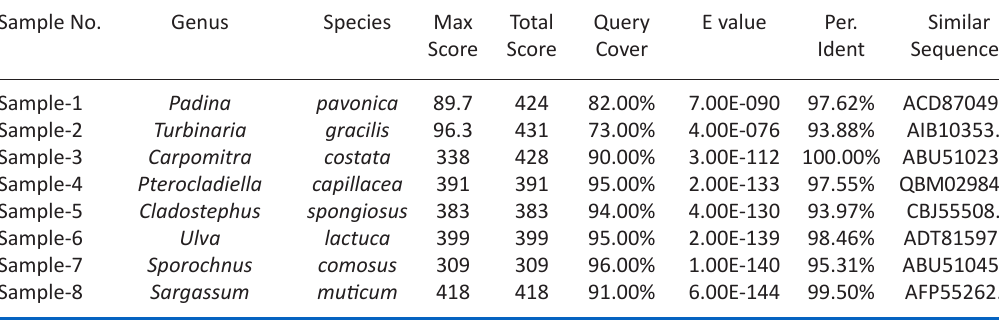
Table 1 . The NCBI blast results details for the 8 seaweeds rbcL sequences Sample